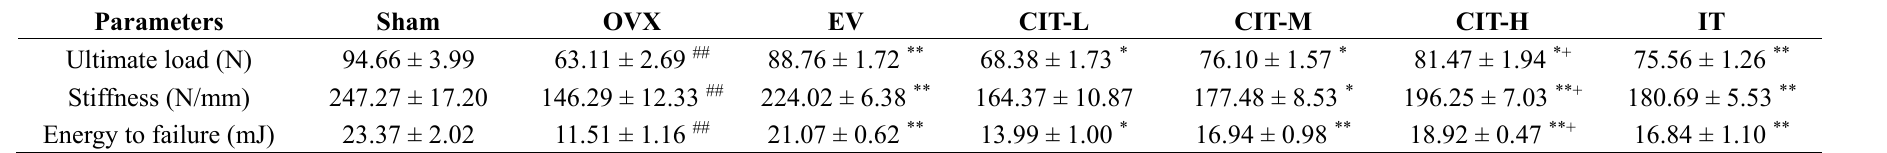
Table 3. Bone biomechanical parameters by three-point bending test.